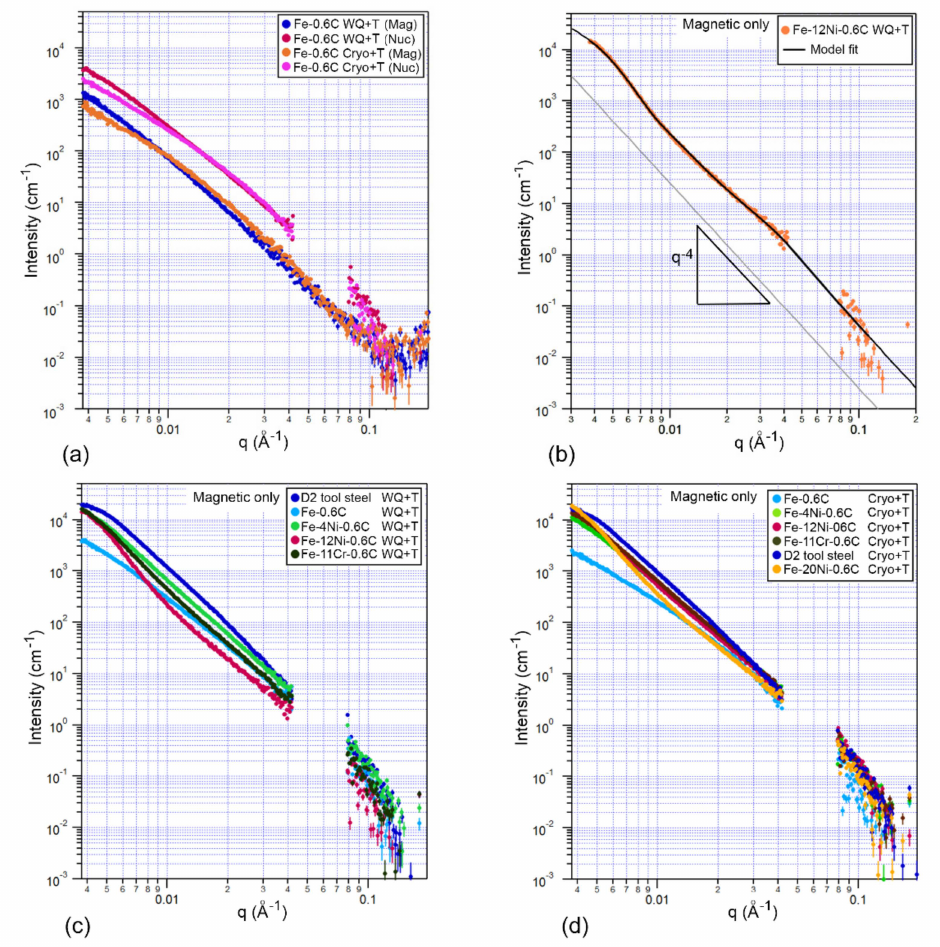
Figure 10. Examples of small angle neutron scattering (SANS) patterns measured on various samples after tempering. Alloys were subject to two di ff erent treatments before tempering: water quenching (WQ + T); and water quenching followed by deep cryogenic treatment (Cryo + T). ( a ): Fe-0.6C alloy: (blue and red), magnetic and nuclear scattering, respectively, water quenched before tempering; (orange and purple), magnetic and nuclear scattering, respectively, water quenched followed by deep cryogenic treatment before tempering. ( b ): (orange): Magnetic SANS data from Fe-0.6C-12Ni water quenched before tempering alloy; (solid black) calculated pattern of q − 4 , a modeled expected asymptote for intensity scattered by a precipitate separated from the matrix by a sharp interface has an asymptotic behavior described by the Porod law. ( c ): Magnetic SANS data from five alloys, water quenched before tempering: (blue) D2 tool steel; (light blue) Fe-0.6C; (green) Fe-0.6C-4Ni; (red) Fe-0.6C-12Ni; (black) Fe-0.6C-11Cr. ( d ): Magnetic SANS data from six alloys, water quenched followed by deep cryogenic treatment before tempering: (light blue) Fe-0.6C; (green) Fe-0.6C-4Ni; (red) Fe-0.6C-12Ni; (black) Fe-0.6C-11Cr; (blue) D2 tool steel; (orange)